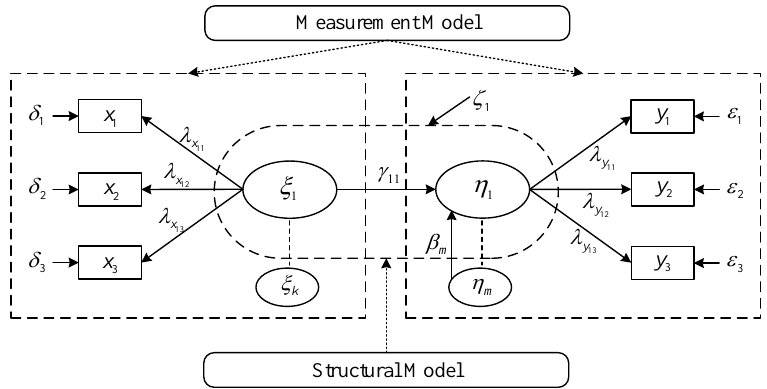
Figure 3. An example of SEM. Table 3. SEM terms and notation.